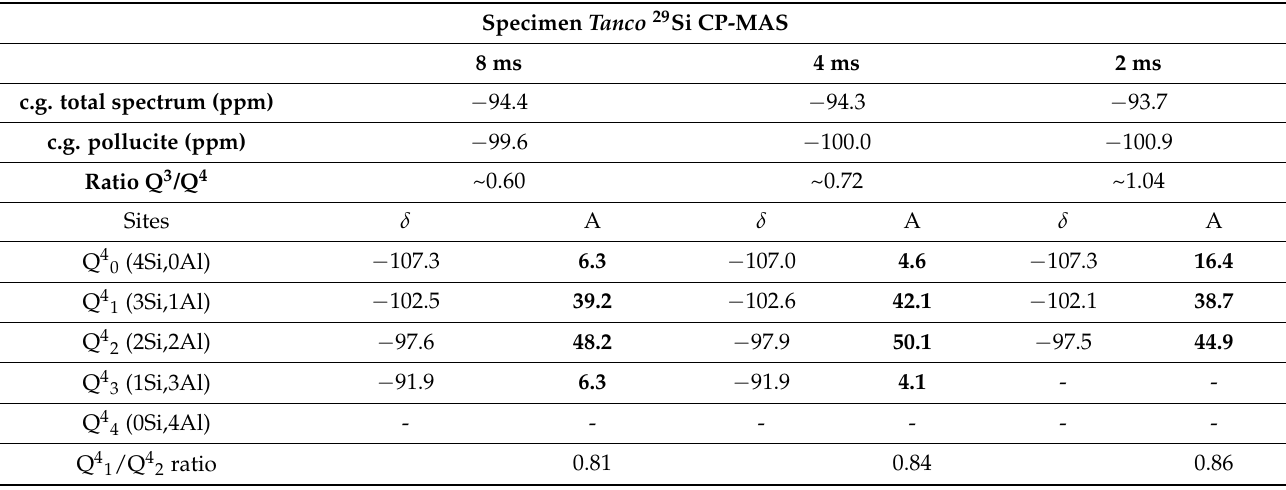
Table 4. Deconvolution of the 29 Si CP-MAS spectra of specimens Tanco